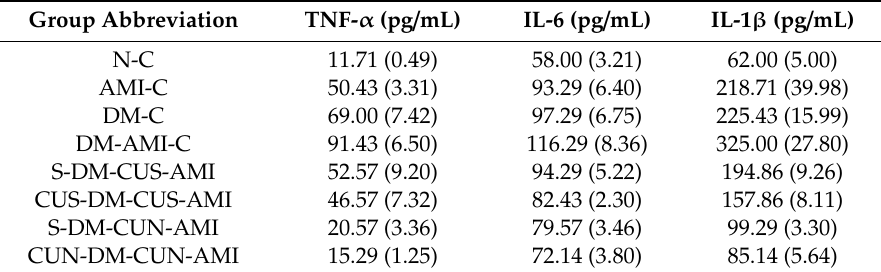
Table 8. Serum levels of pro-inflammatory cytokine.